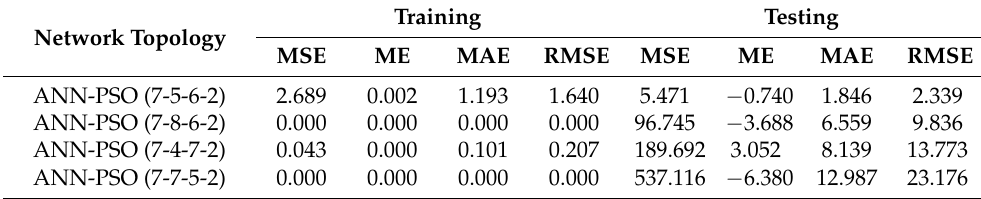
Table 7. Statistical indices of artificial neural network (ANN) with different topology.